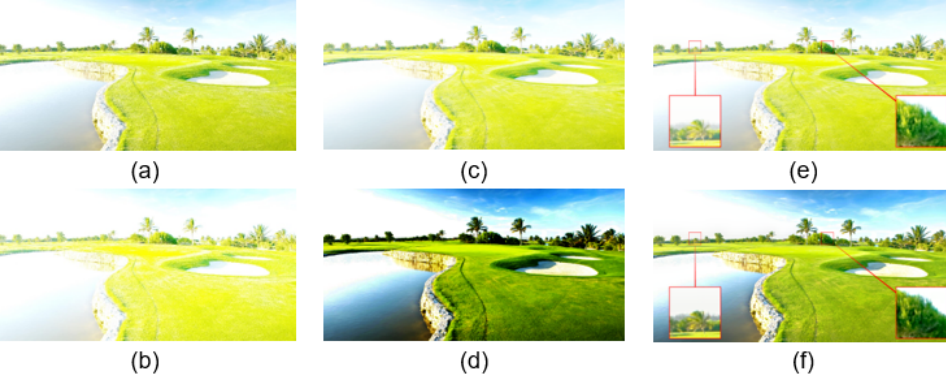
Figure 2. Comparison of intermediate virtual images. ( a , b ): Input images I 1 and I 2 ; ( c , d ) are the intermediate virtual images using [9] and our method; ( e , f ) are the fusion results using [9] and